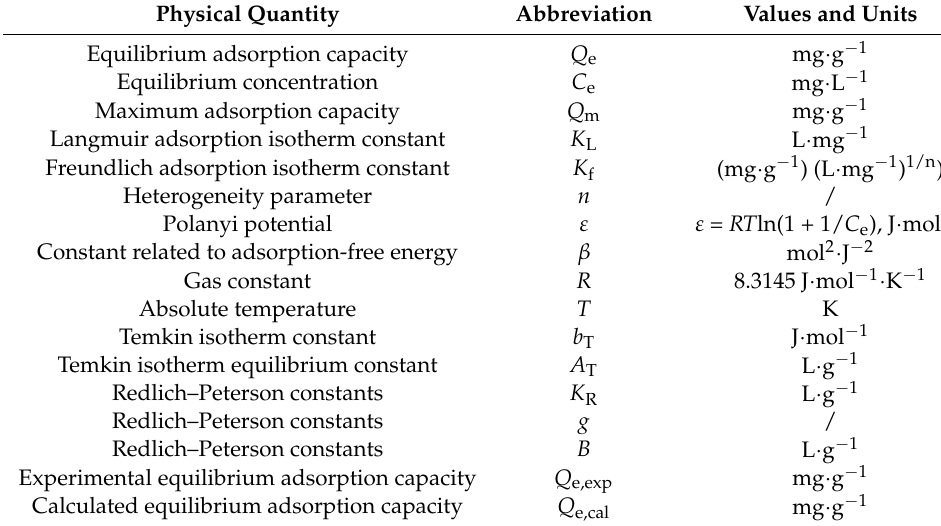
Table 2. Physical quantities in five adsorption isotherm